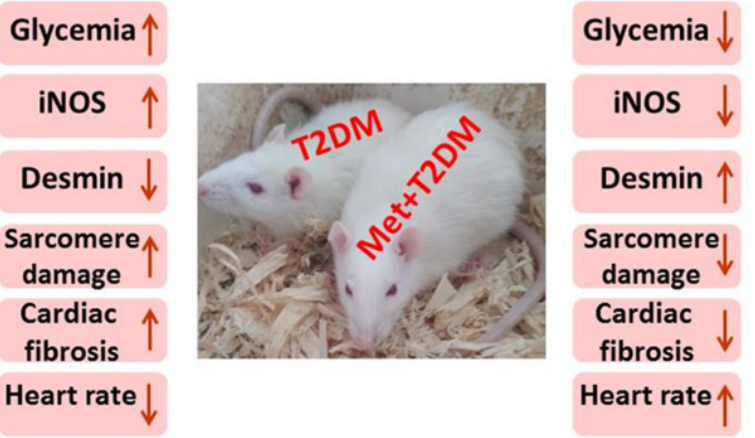
Figure 6. The proposed model for diabetes-induced cardiomyopathy (left side) appears inhibited by metformin (right side). ↑ = increased; ↓ = decresed. iNOS: inducible nitric oxide synthase; T2DM: type 2 diabetes mellitus; Met: metformin.